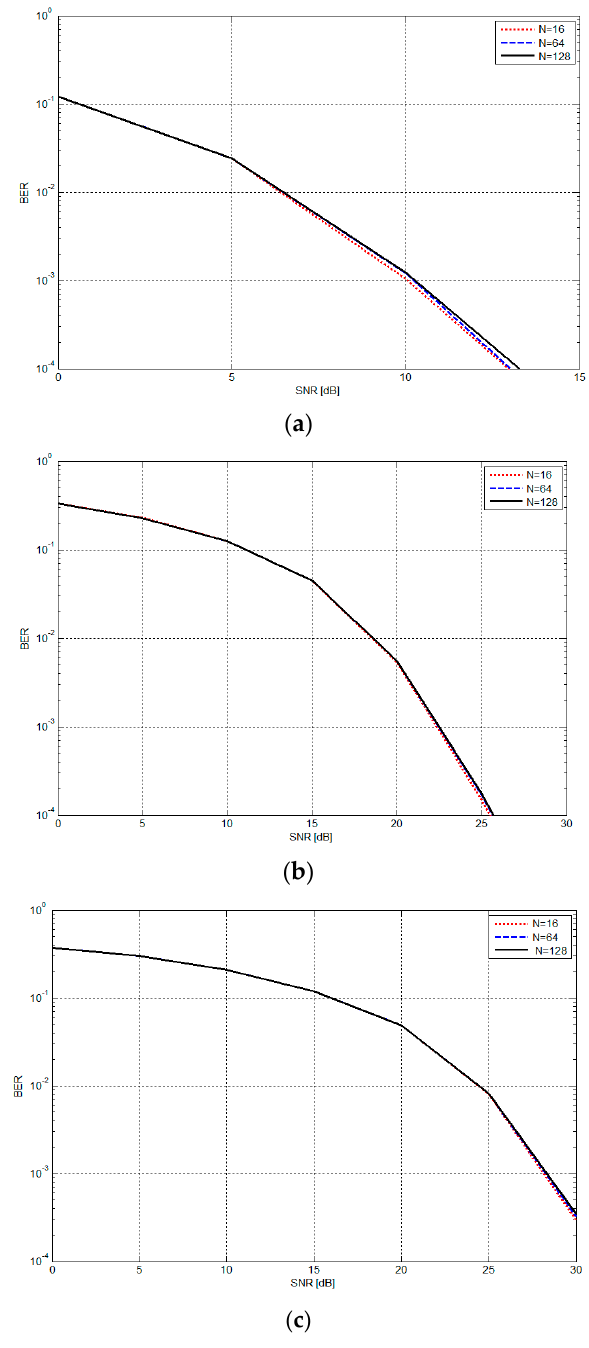
Figure 6. BER of STC OTDM at different subcarriers and L = 9 for: ( a ) QPSK; ( b ) 64-QAM; and ( c ) 256-QAM.